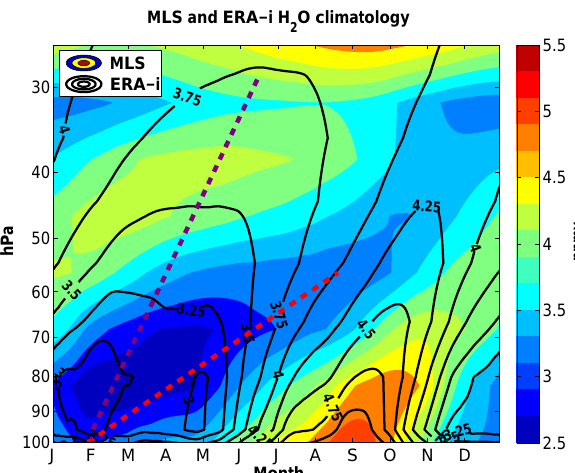
Figure 2. The climatological zonal mean tropical (10 ◦ S–10 ◦ N) tape recorder signal (the water vapor mixing ratio in ppmv) based on MLS (colors) and ERA-i reanalysis (black contours). The red and purple dotted lines roughly indicate the evolution of the dry minima with time for MLS and ERA-i,